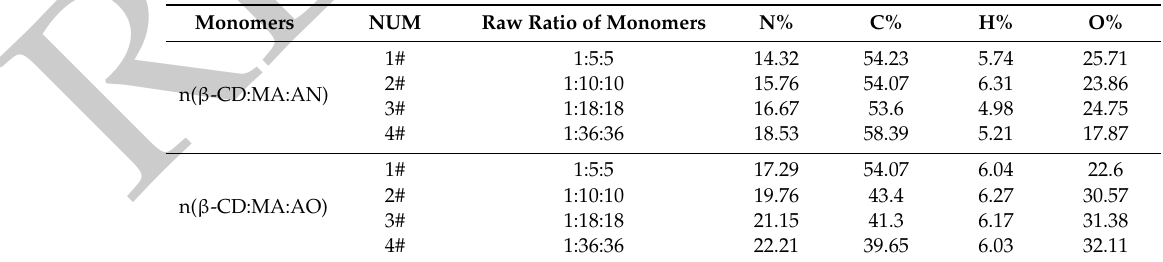
Table 1. Element analysis of sample before and after reaction with hydroxylamine.